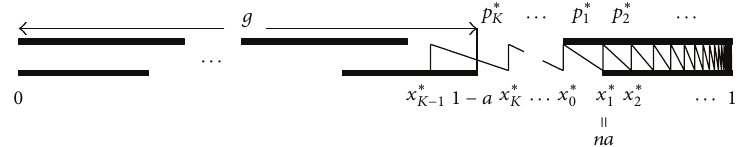
Figure 19: “Mirror” construction scheme of density 𝑝(𝑥) in the case of arbitrary 𝑛 ≥ 2